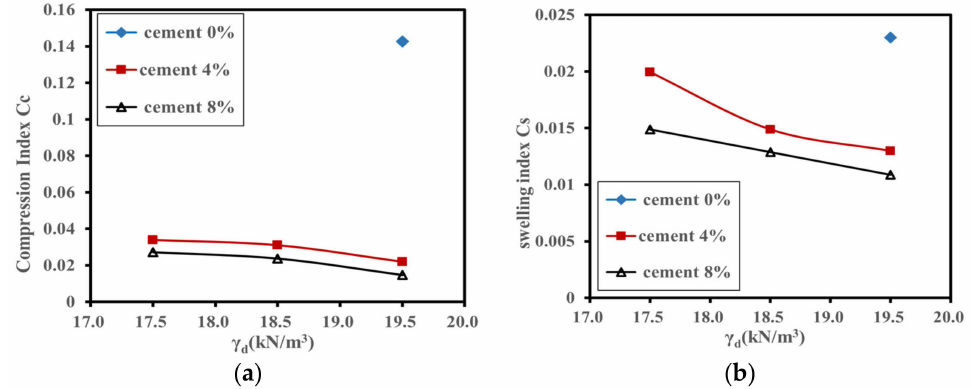
Figure 19. A comparison of compression index C c and swelling index C s versus testing soils dry density levels: ( a ) C c versus γ d ; ( b ) C s versus γ d